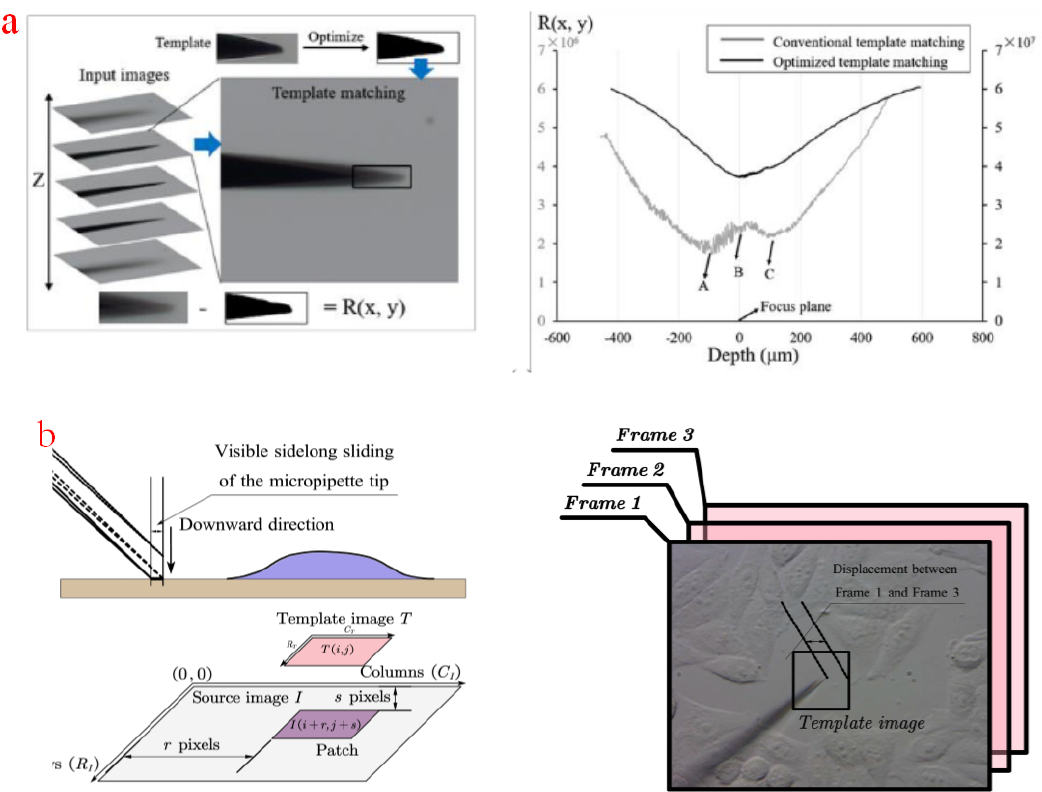
Figure 8. Template matching methods. ( a ) Optimized template matching method with gradient differences. Adapted with permission from Reference [148]; ( b ) Three-frame template matching method. Adapted with permission from Reference [151].